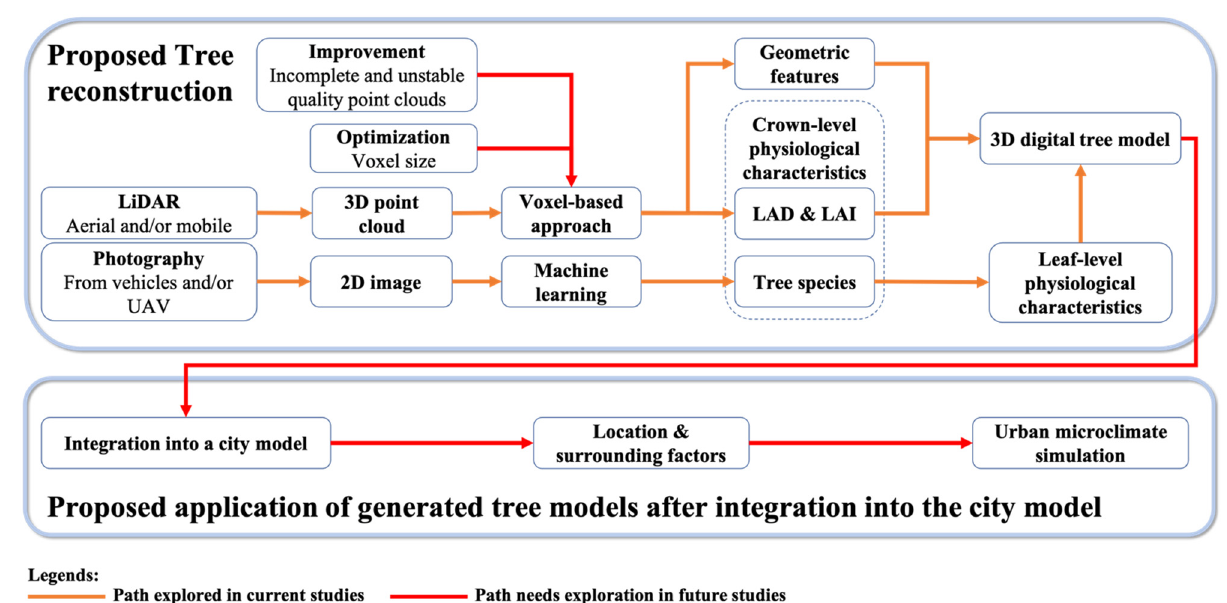
Figure 6. Proposed tree reconstruction approach and application of reconstructed tree models.